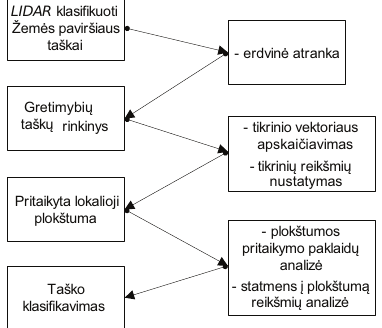
Fig. 1. The algorithm of plane fitting and point